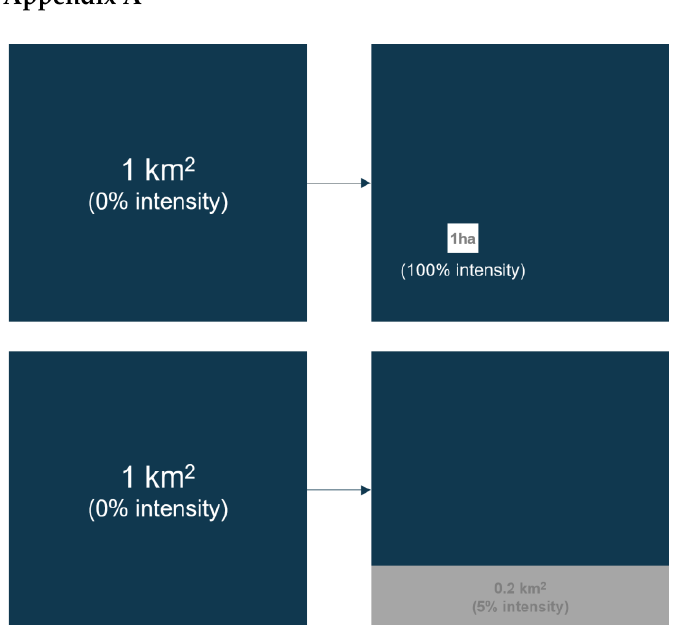
Figure A1. Examples of potential combinations of spatial patterns, area, and intensity changes that could cause a 1% increase in nightlight intensity within the time series trend of a single pixel. Table A1. Significant Mann-Kendall pixel-level trends at varying levels of alpha significance.1. MKtau p -Value